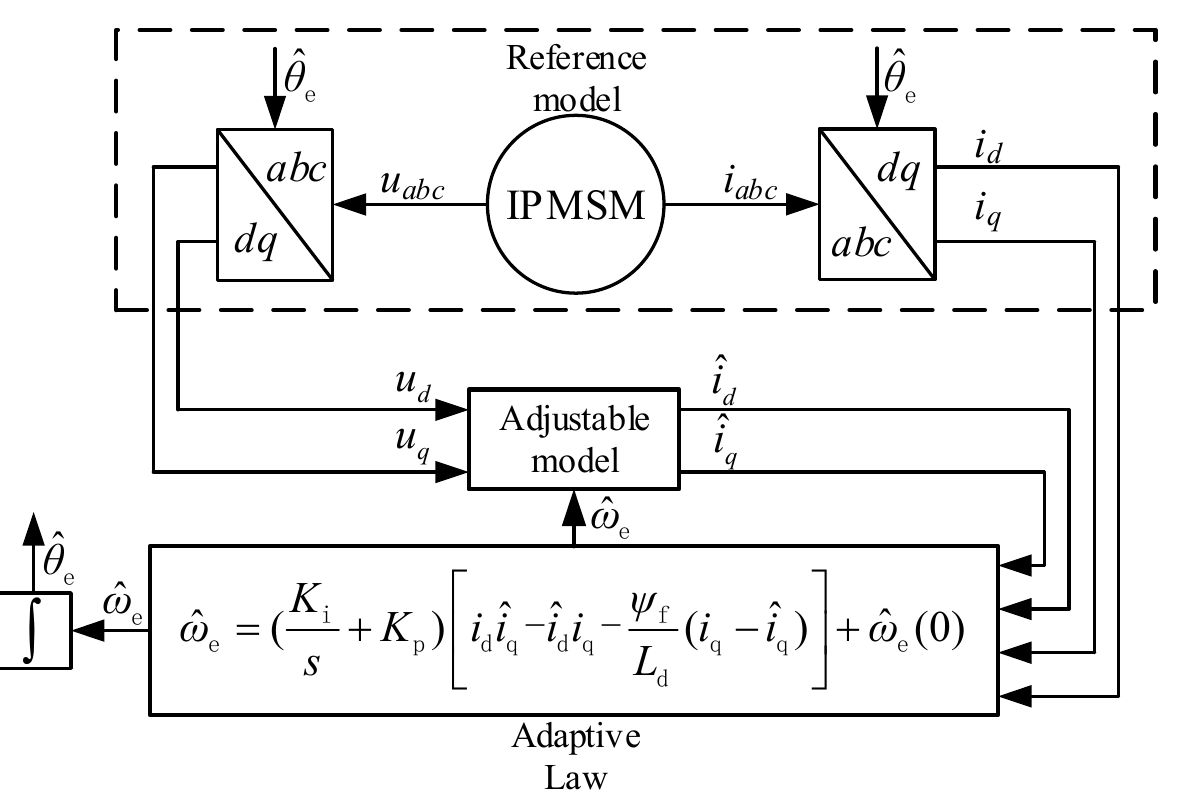
Figure 4. Block diagram of MRAS rotor position and speed estimation system.